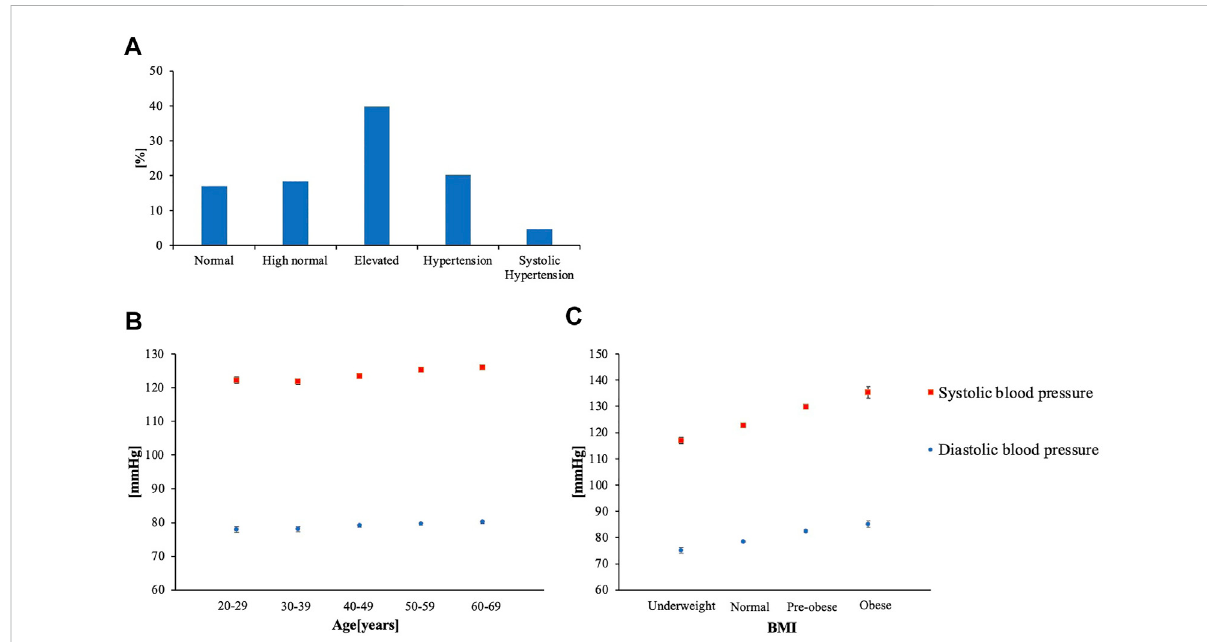
FIGURE 2 (A) Percentage distribution of BP categories (B) Age-speci fi c mean BP (C) BMI-speci fi c mean BP (Underweight: < 18.5, Normal: 18.5 ≤ BMI < 25.0, pre-obese:25.0 ≤ BMI < 30.0, Obese: 30.0 ≤